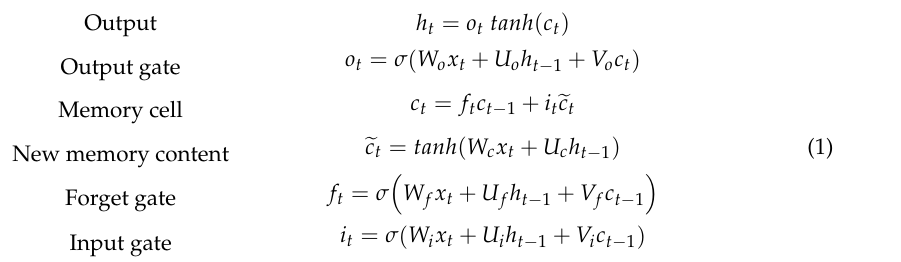
Figure 1. Long short-term memory (LSTM) model (source: [27]).